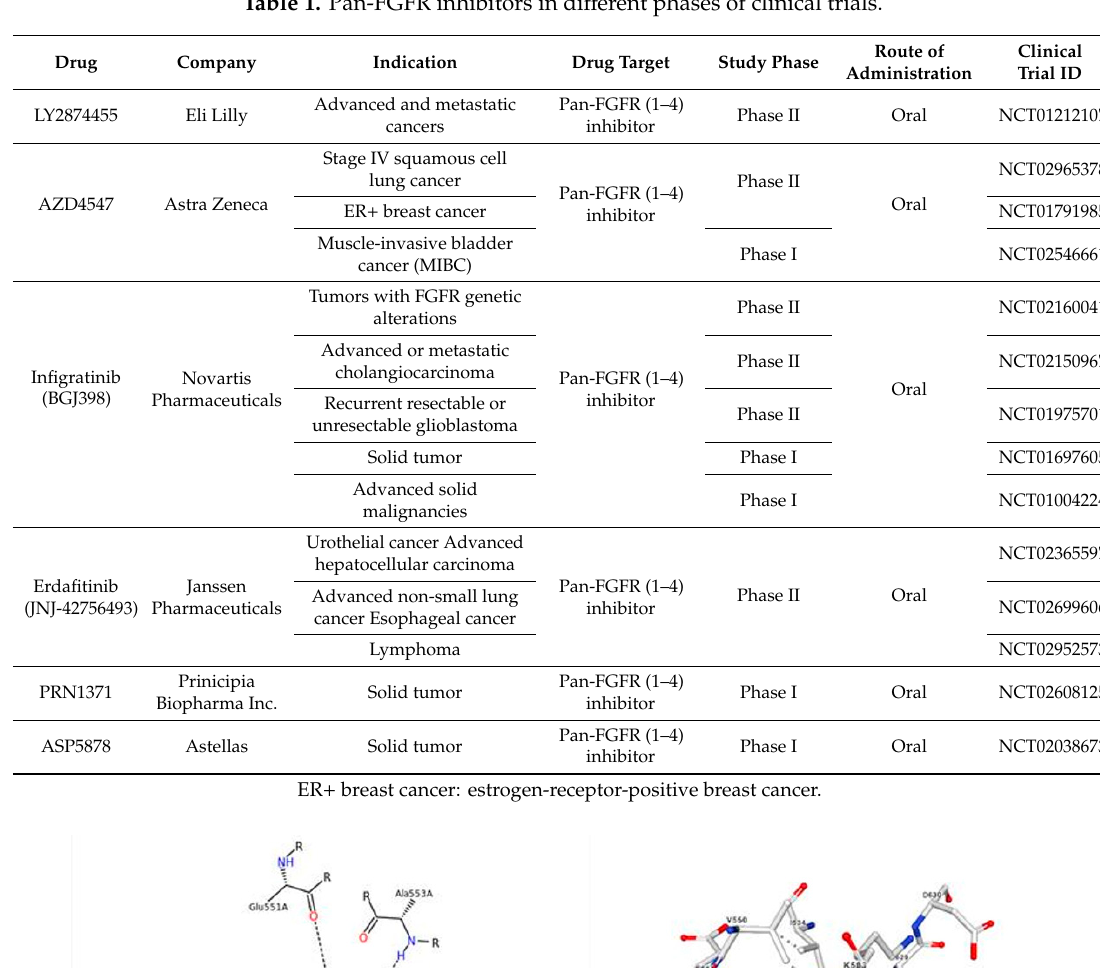
Table 1. Pan-FGFR inhibitors in di ff erent phases of clinical trials.